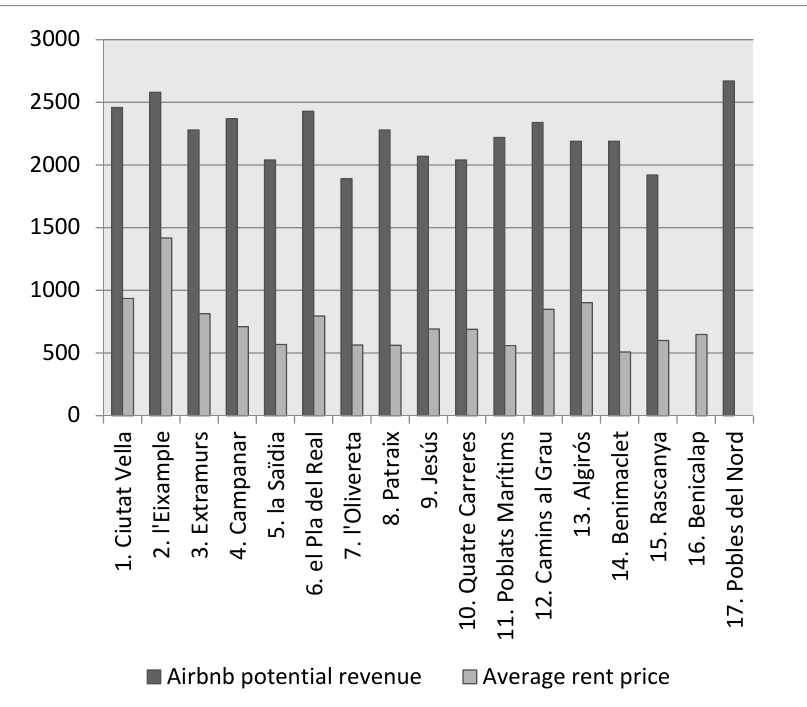
Figure 10. Airbnb potential revenue versus average rent price per district in Valencia, Source: [27] and [33].